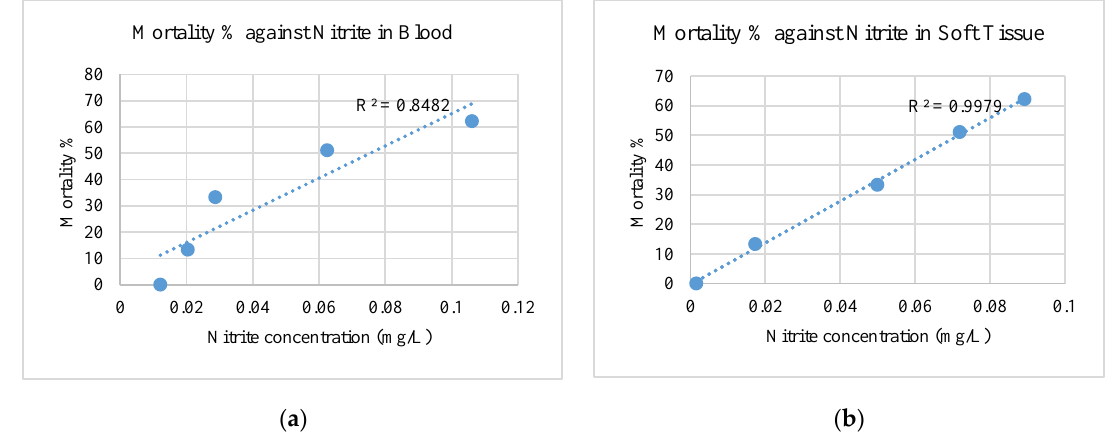
Figure 4. Blood cockle mortality percentages vs. the concentration of nitrite in the blood ( a ) and soft tissue ( b ) samples of nitrite-treated cockles.